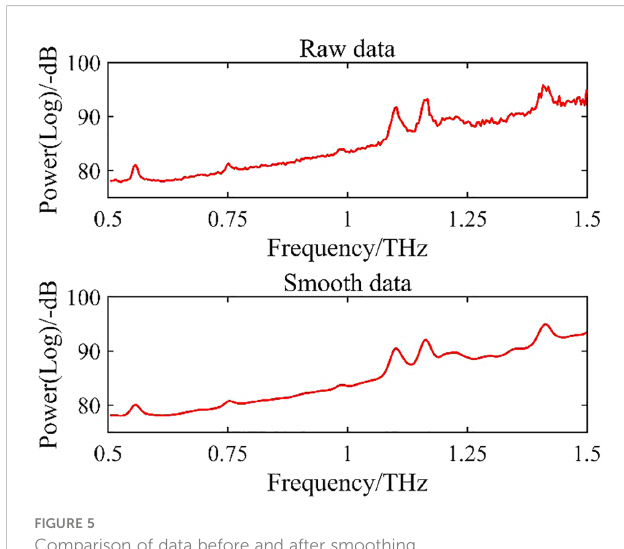
FIGURE 5 Comparison of data before and after smoothing.